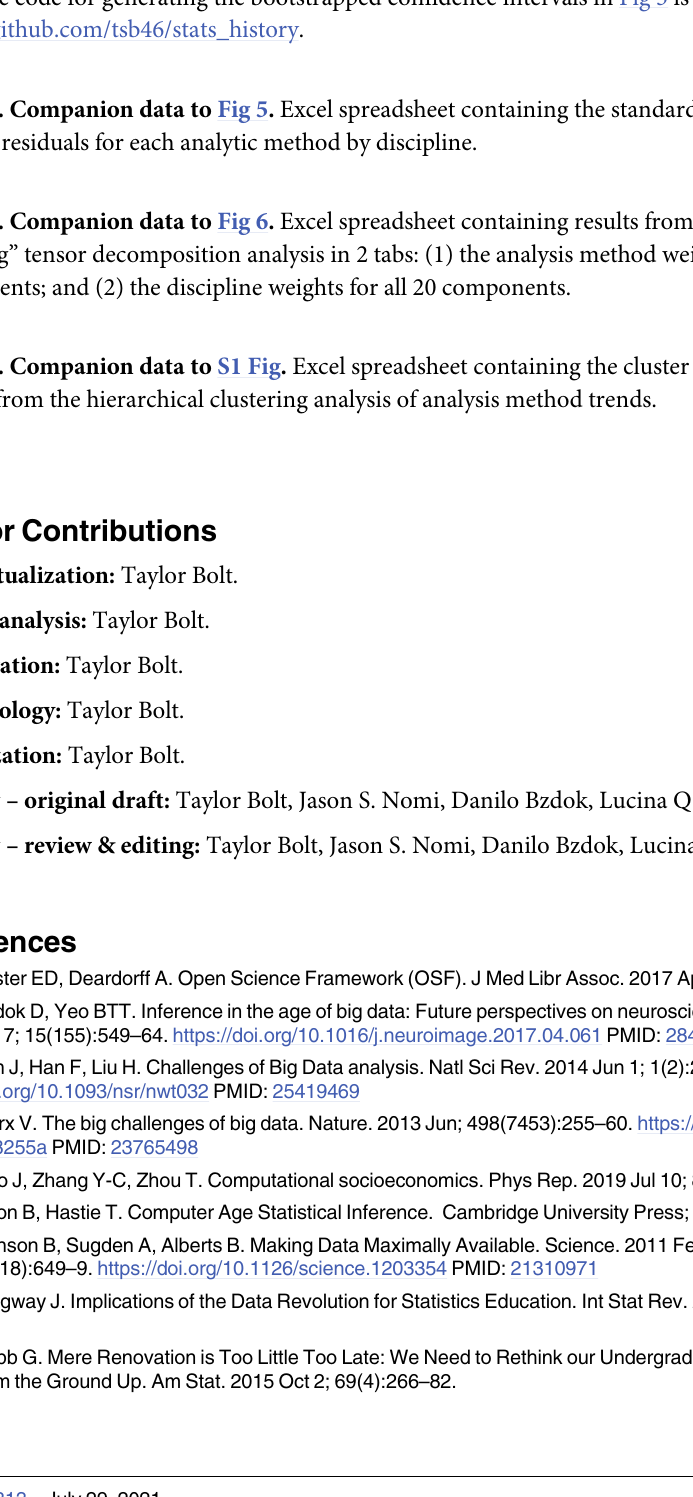
S3 Data. Companion data to Fig 5. Excel spreadsheet containing the standardized chi-